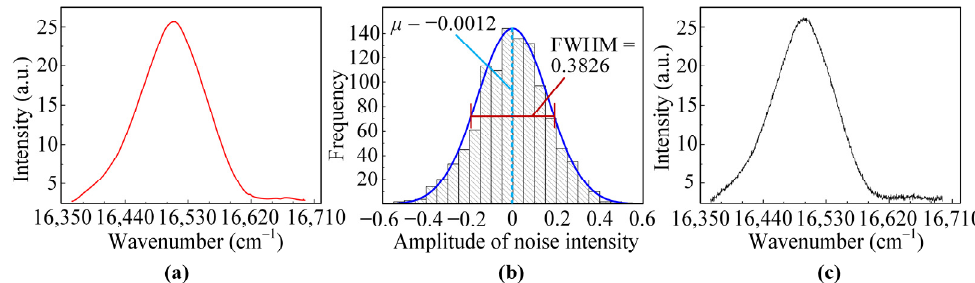
Figure 4. ( a ) Smooth curve obtained by multipeak fitting; ( b ) noise distribution; ( c ) simulated spectrum with introduced noise.